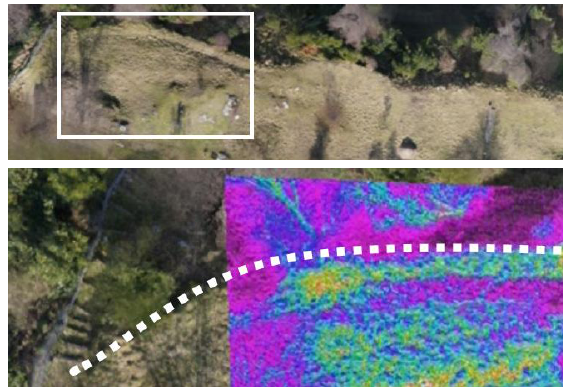
Fig. 13. Remains of a (supportive /defensive) wall for the site Hilltop